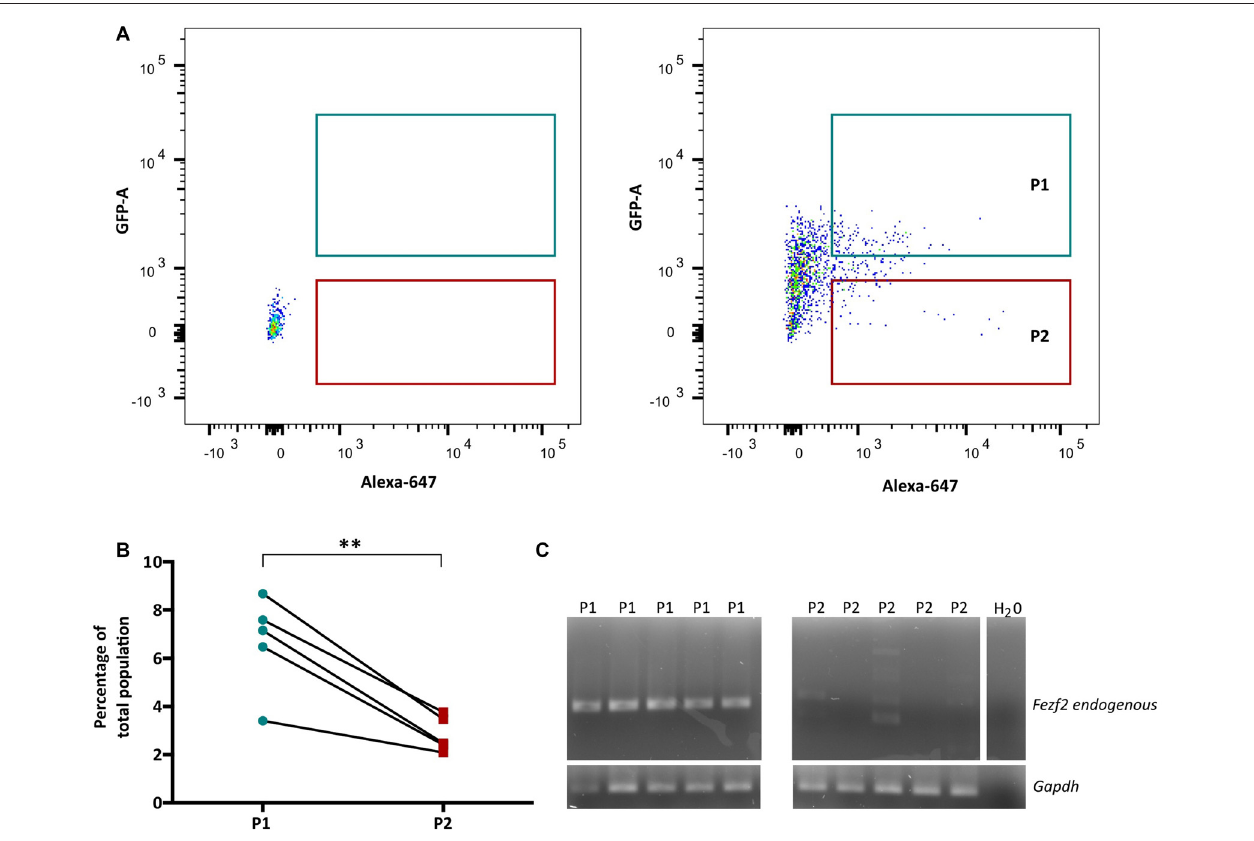
FIGURE 2 | Fezf2+ve and Fezf2 − ve intratelencephalic projection neurons (IT-PNs) are separated according to their fluorescence profiles. (A) Representative plot of Alexa 647 (CTB647; x-axis) and GFP detection (y-axis) during FACS. The fluorescence profile of a wildtype animal was used to set the gates for GFPCTB+ (GFP and CTB646; P1) and CTB+ (CTB647; P2) positive cells during sorting. (B) Flow cytometry analysis of cells gated as GFPCTB+ or CTB+. The percentage of GFPCTB+ neurons was significantly greater that CTB+ neurons ( ∗∗ p = 0.005, paired t -test; n = 5). (C) RT-PCR analysis of Fezf2 expression in sorted samples. A specific (324 bp) Fezf2 product was detected in GFPCTB+ ( Fezf2+ve ) IT-PNs (P1), but not CTB+ ( Fezf2 − ve ) IT-PNs (P2). Housekeeping gene Gapdh was used as a positive control and detected in all samples (190 bp